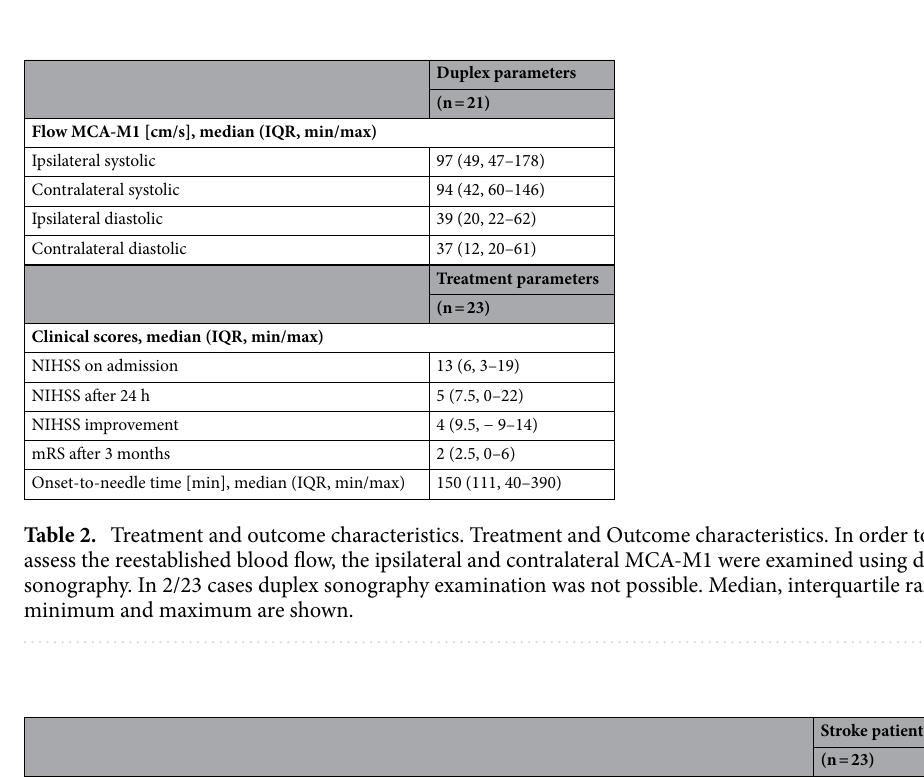
QSM susceptibility cortical vein values, median (IQR, min/max) Stroke